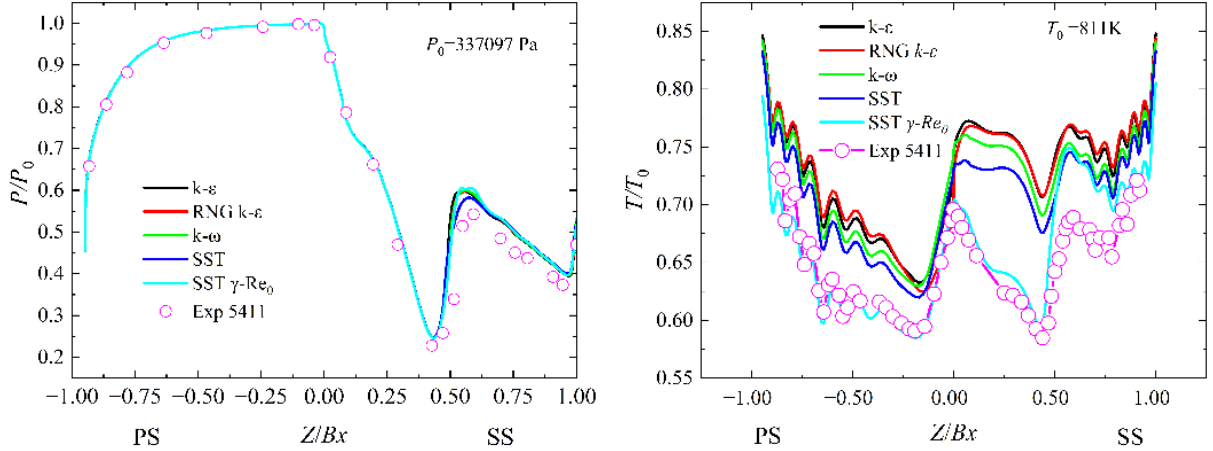
Figure 6. Computational grids of Mark II for low-Re turbulence models.